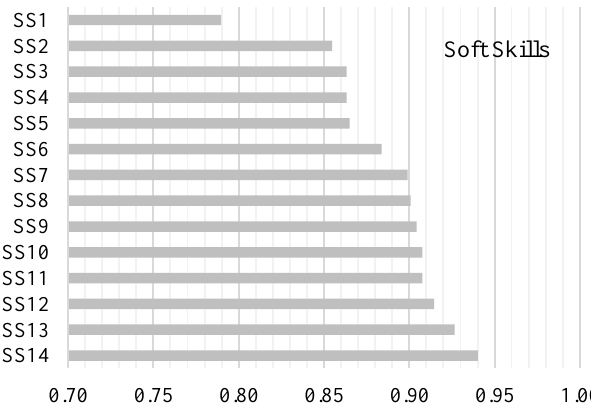
Fig. 4. Relative importance index obtained for soft